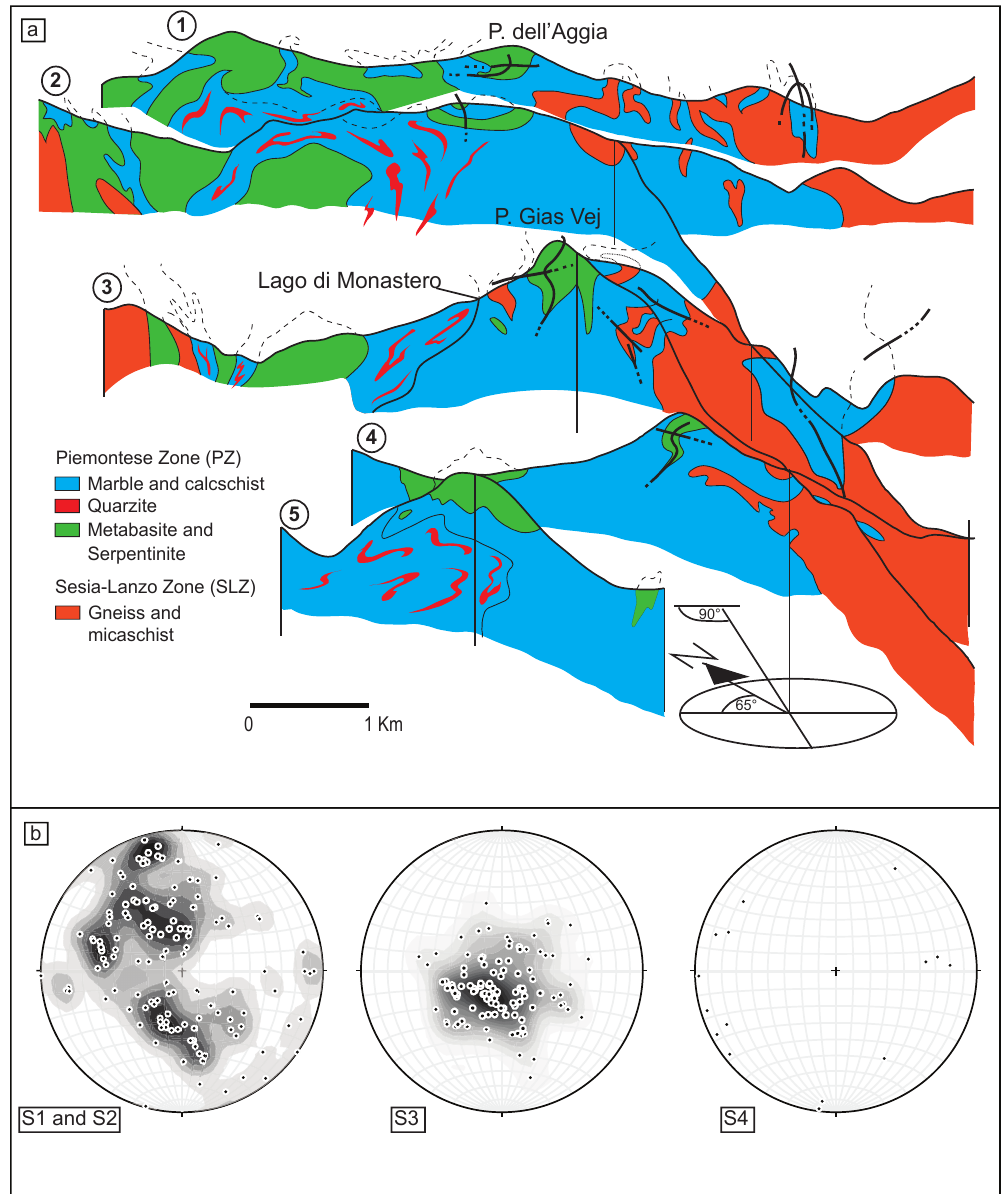
Figure 3. ( a ) Simplified cross sections (1-5) of Gias Vej - Lago di Monastero area redrawn after [13] showing the complex 3D structural pattern, due to transpositive folding and refolding during high pressure Alpine metamorphism and exhumation-related re-equilibrations, responsible for the multi-scale mingling, which originate a new cm to km-scale lithostratigraphy between continental rocks and calcschists. Axial plane trajectories of successive groups of folds are distinguished by the number of dots. Traces of the cross sections (1-5) are reported in Figure 2. ( b ) Stereographic projections (Schmidt net, lower hemisphere) of successive foliations (S1, S2, S3 and S4) of Gias Vej area (density plots and